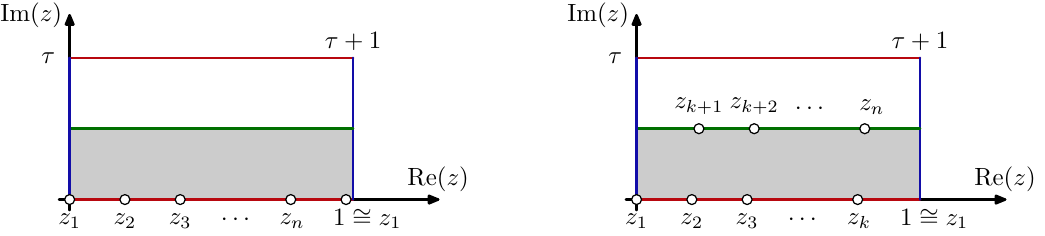
Figure 2 . Insertion points for open-string con(cid:12)guration-space integrals on the cylinder can reside either on one boundary only ( planar case , left panel) or be located at both cylinder boundaries ( non-planar case , right panel). Following the parametrizations in [53, 54], the cylinder is obtained from a torus with purely imaginary value for (cid:28)